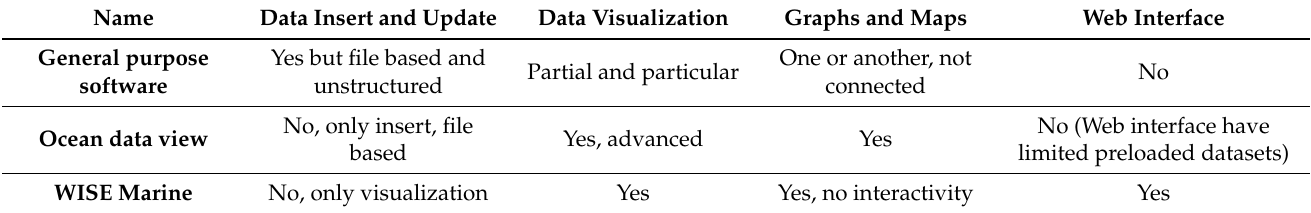
Table 1. Main properties of related